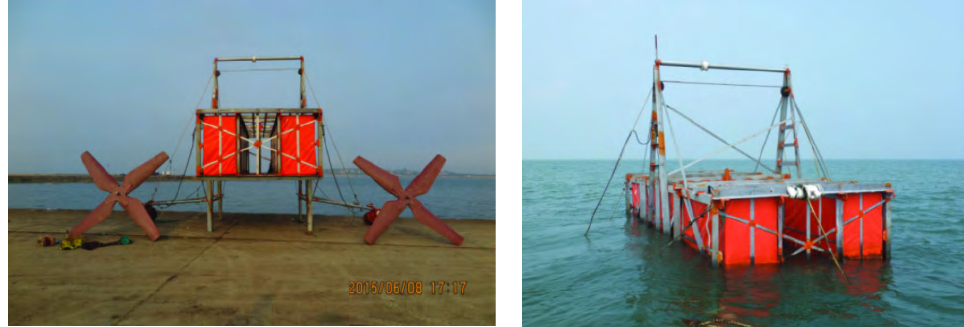
Figure 11. A 5 kW power supply device for offshore instrument. Reproduced from [1].